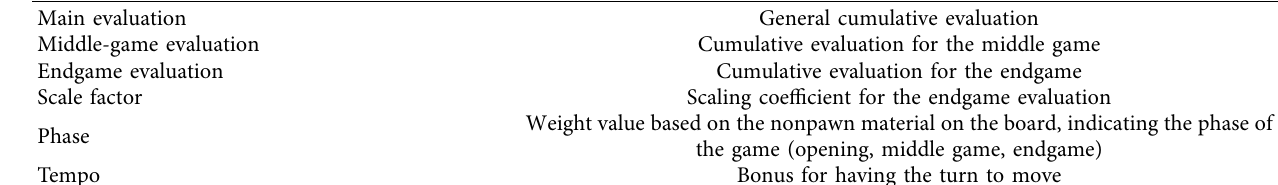
Table 2: Stockfsh evaluation functions and